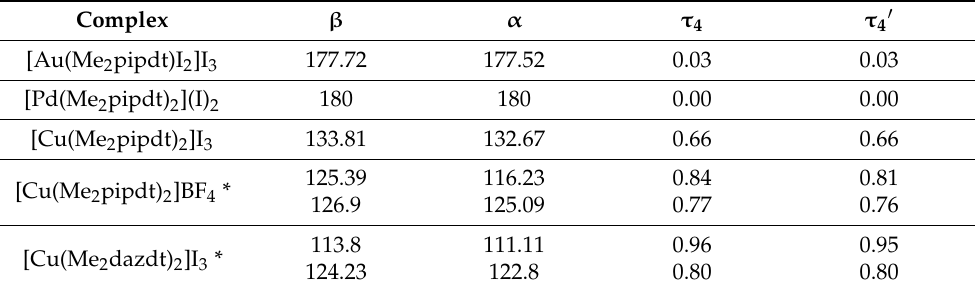
Figure 5. ( a ) Molecular structure of complex [Cu(Me 2 dazdt) 2 ]I 3 ( 5 ) with thermal ellipsoids plotted at the 50% probability level. ( b ) Portion of the crystal packing. Intermolecular interactions are depicted as dashed bonds. Halogen bond interac- tion is reported in Å . Table 2. Values of τ 4 and τ 4 ′ indices with coordination angles β and α (β > α). Table 2. Values of τ 4 and τ 4 (cid:48) indices with coordination angles β and α ( β > α ). Complex